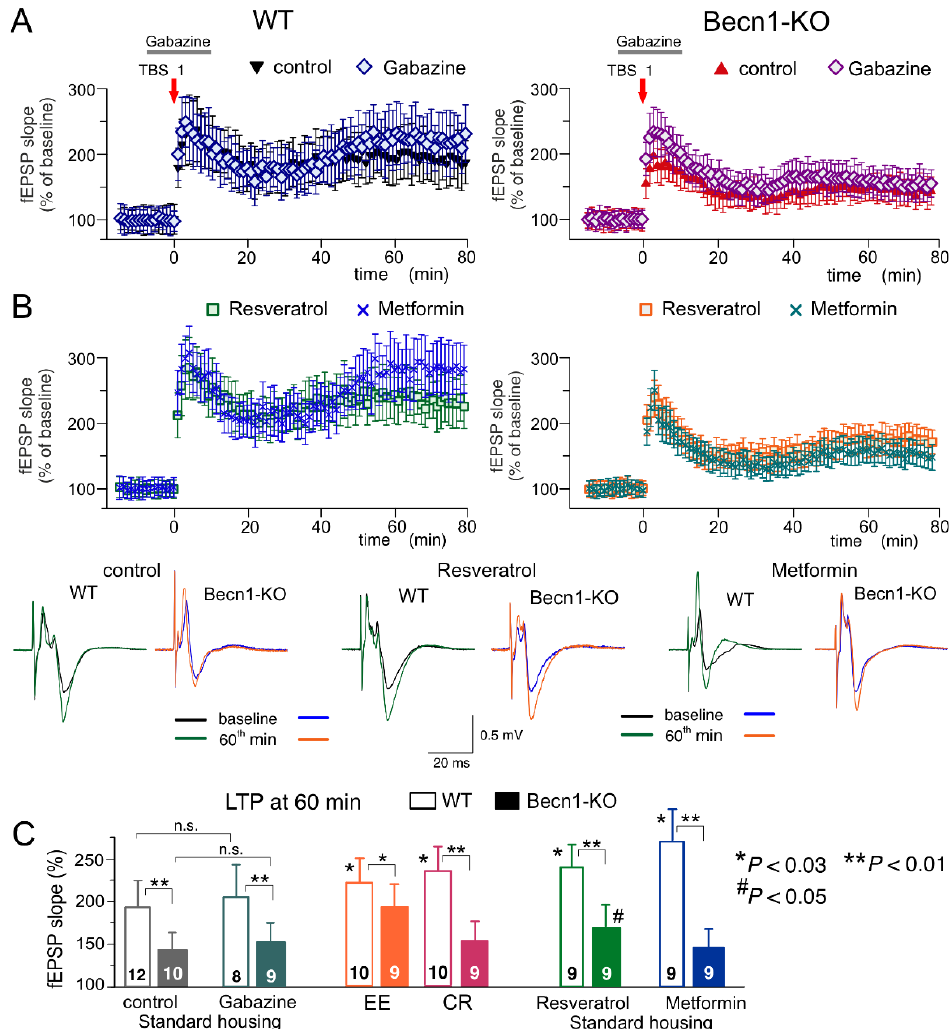
Figure 8. Impact of autophagy impairment on long-term synaptic plasticity in the CA1 hippocampal area. LTP of the field EPSPs was induced in the CA1 hippocampal area by one episode of theta-burst stimulation (TBS), as described in Methods . ( A , B ) The time course of changes in the slopes of fEPSPs recorded in the wild-type (left) and Beclin1-deficient mice (right) under different conditions. Dots in the graphs represent the average of six consecutive fEPSPs; data are shown as means ± SDs for 7 – 15 experiments (as indicated in panel C). Data were normalized to the fEPSP slope averaged over the 10 min period prior to the TBS. ( A ) LTP was induced in the CA1 neurons of SH mice under control conditions and in the presence of the GABA A receptor antagonist gabazine (1 µM) applied, as indicated in the graphs. ( B ) The CA1 LTP recoded in the slices of SH mice after preincubation of brain slices with metformin (5 µM) or resveratrol (5 µM) for >4 h. The insets show the representative average fEPSP waveforms recorded before and 60 min after the TBS. ( C ) The pooled data on the magnitude of the CA1 LTP in mice of both genotypes at different conditions. Graphs show the magnitude of LTP evaluated as a relative increase in the fEPSP slope at 60 min, averaged across a 10 min time window. Data are shown as the means ± SDs for the numbers of experiments indicated. The statistical significance (two-population unpaired t -test) of the differences between genotypes and treatment groups is indicated by different symbols as follows: (*) effect of EE, CR or drug in the WT mice as compared to the control; (#) effect of EE, CR or drug in the Beclin1-deifient mice as compared to the control; (** or *) difference between WT and Beclin1-deficient mice. Note the significant decrease in the LTP magnitude in the Beclin1-KO mice and the significant effect of EE and resveratrol in the Beclin1-KO mice.